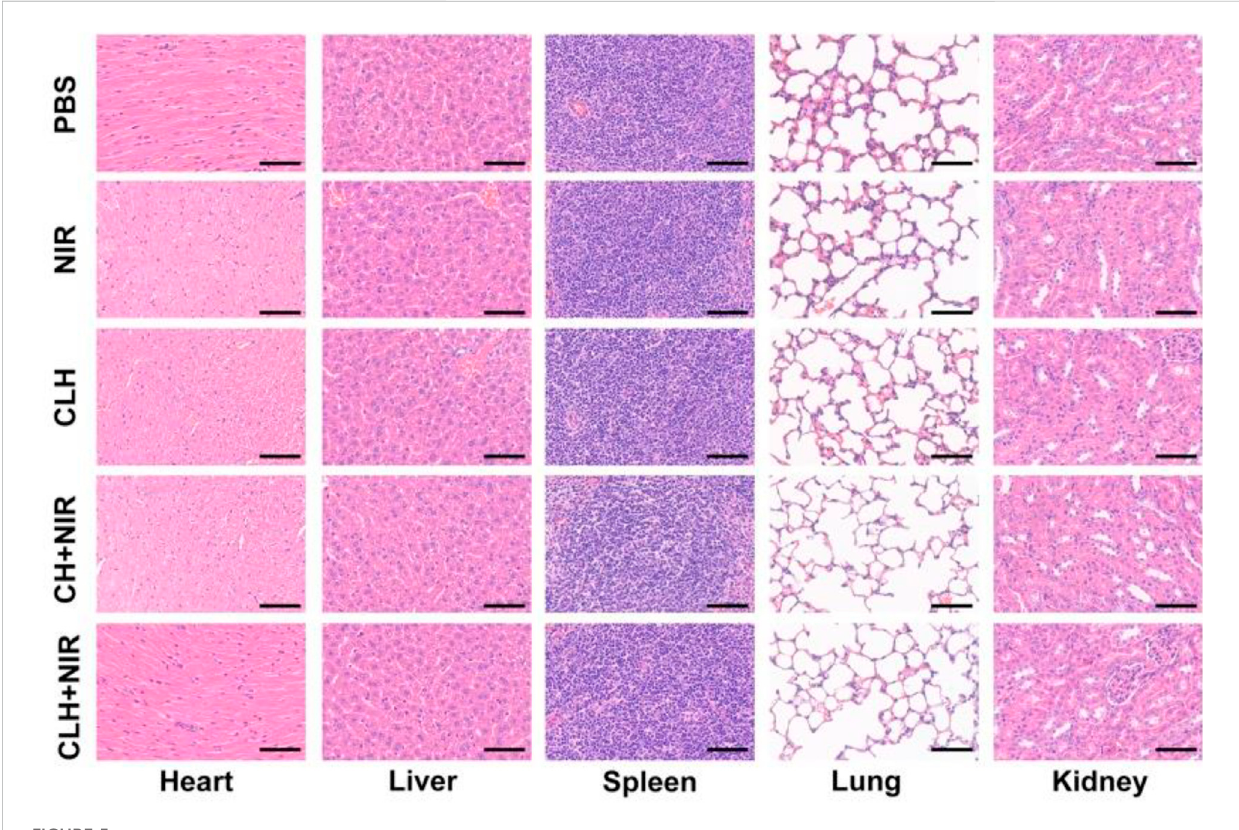
FIGURE 5 H&E staining of major organs post-treatments. Scale bars: 100 μ